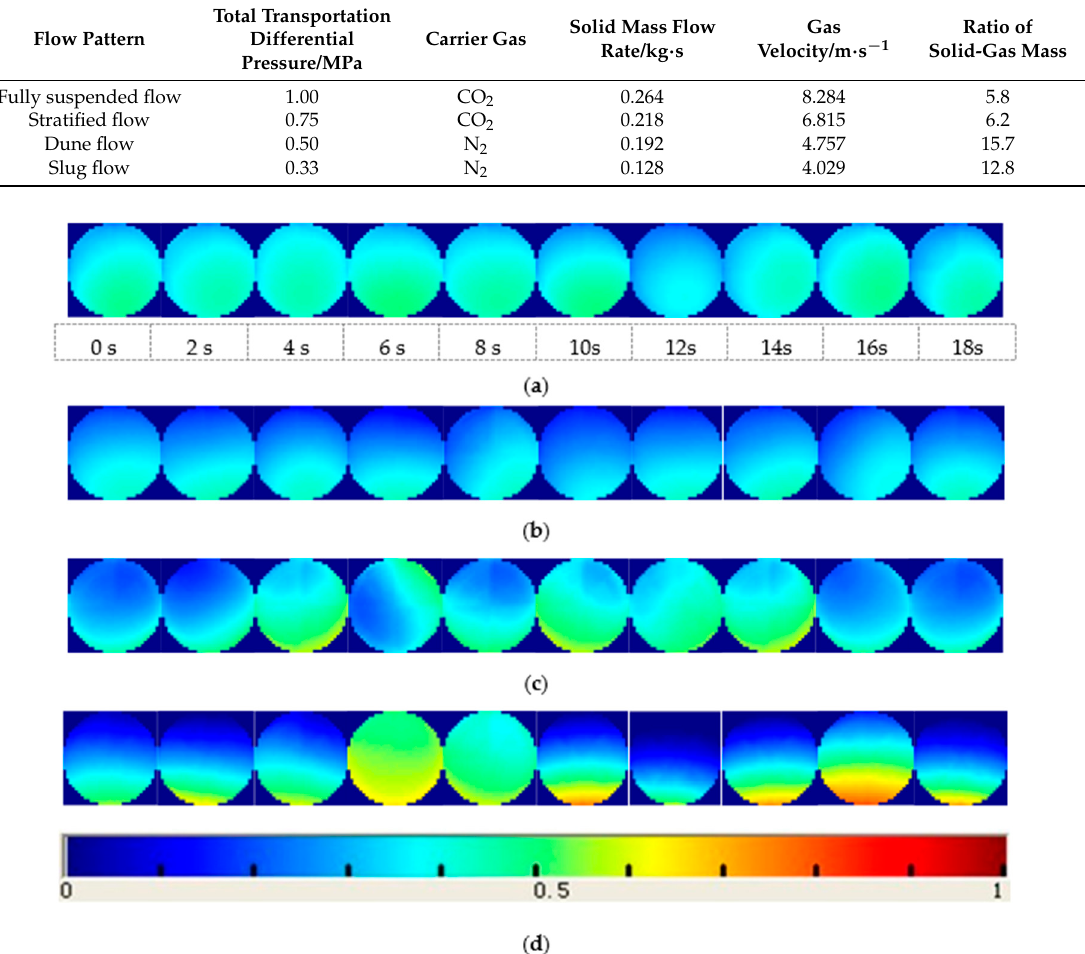
Figure 10. ECT images of four flow patterns ( a ) fully suspended flow; ( b ) stratified flow; ( c ) dune flow; ( d ) slug flow.